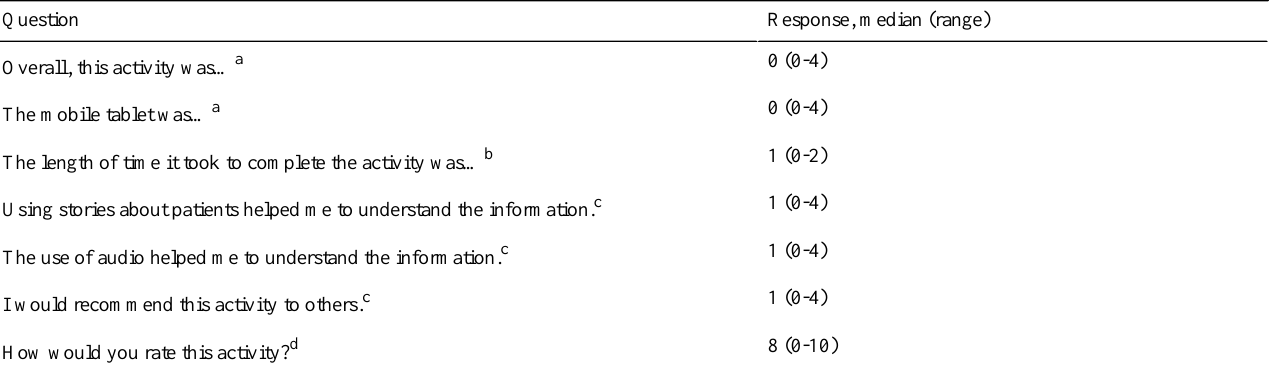
Table 3. Survey indicating user satisfaction with the patient safety tool.